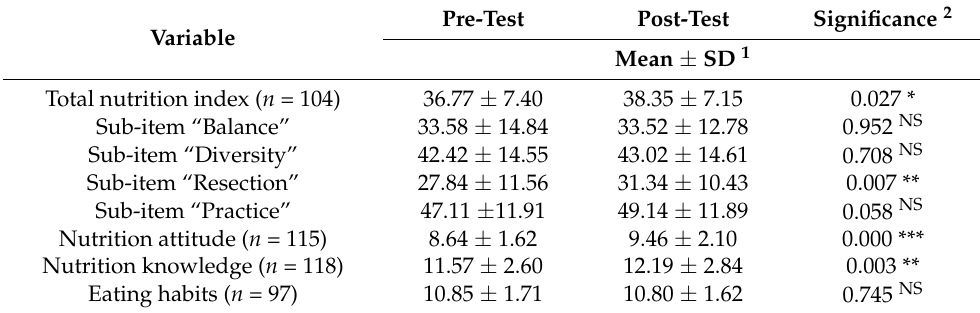
Table 6. Comparison of factors related to eating behavior in primary carers before and after the 12-session horticultural activity program ( N = 122).